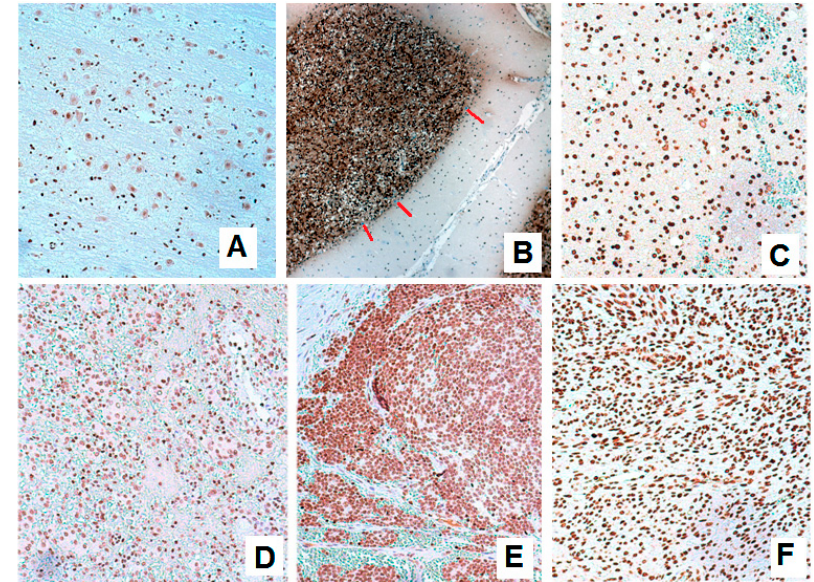
Figure 1. BarH like homeobox 1 (BARHL1) expression in normal and neoplastic specimens from the nervous system. ( A ) Staining in brain cortex. ( B ) Cerebellum showing a strong positive expression in granular layer cells (note: the absence of expression in Purkinje cells, indicated by red lines). Specimens from glioma ( C ), meningioma ( D ), neuroblastoma ( E ) and malignant peripheral nerve sheath tumors ( F ) showing strong positivity for BARHL1 expression. ×20 original magnifications.